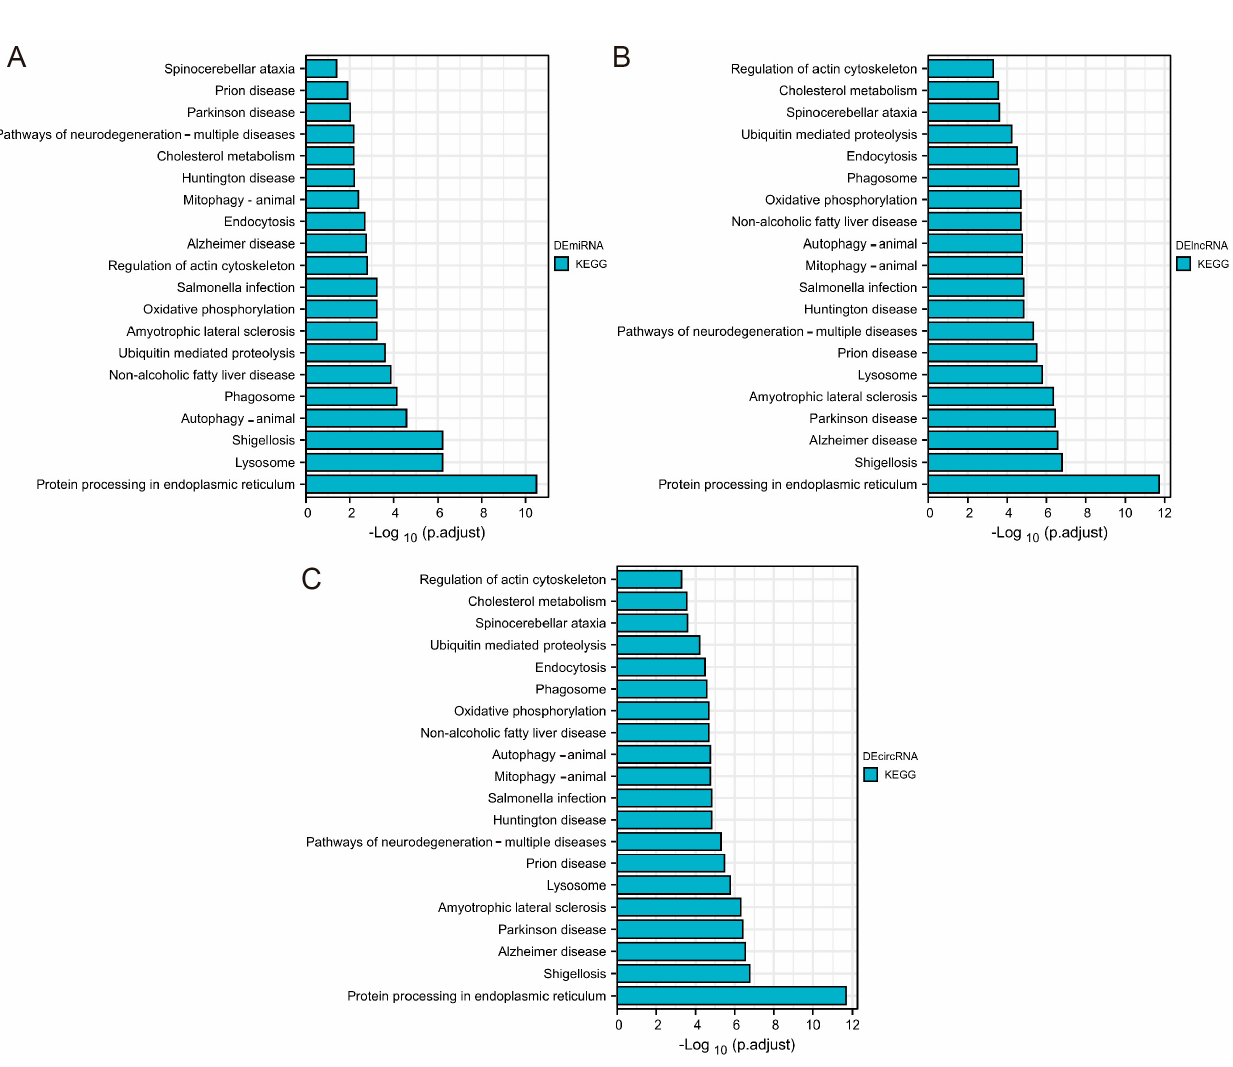
Figure 4. ( A–C ) Top 20 KEGG enrichment pathway of target mRNAs related to DEmiRNA ( A ), Figure 4. ( A – C ) Top 20 KEGG enrichment pathway of target mRNAs related to DEmiRNA ( A ), DElncRNA ( B ), and DEcircRNA ( C ). DElncRNA ( B ), and DEcircRNA ( C